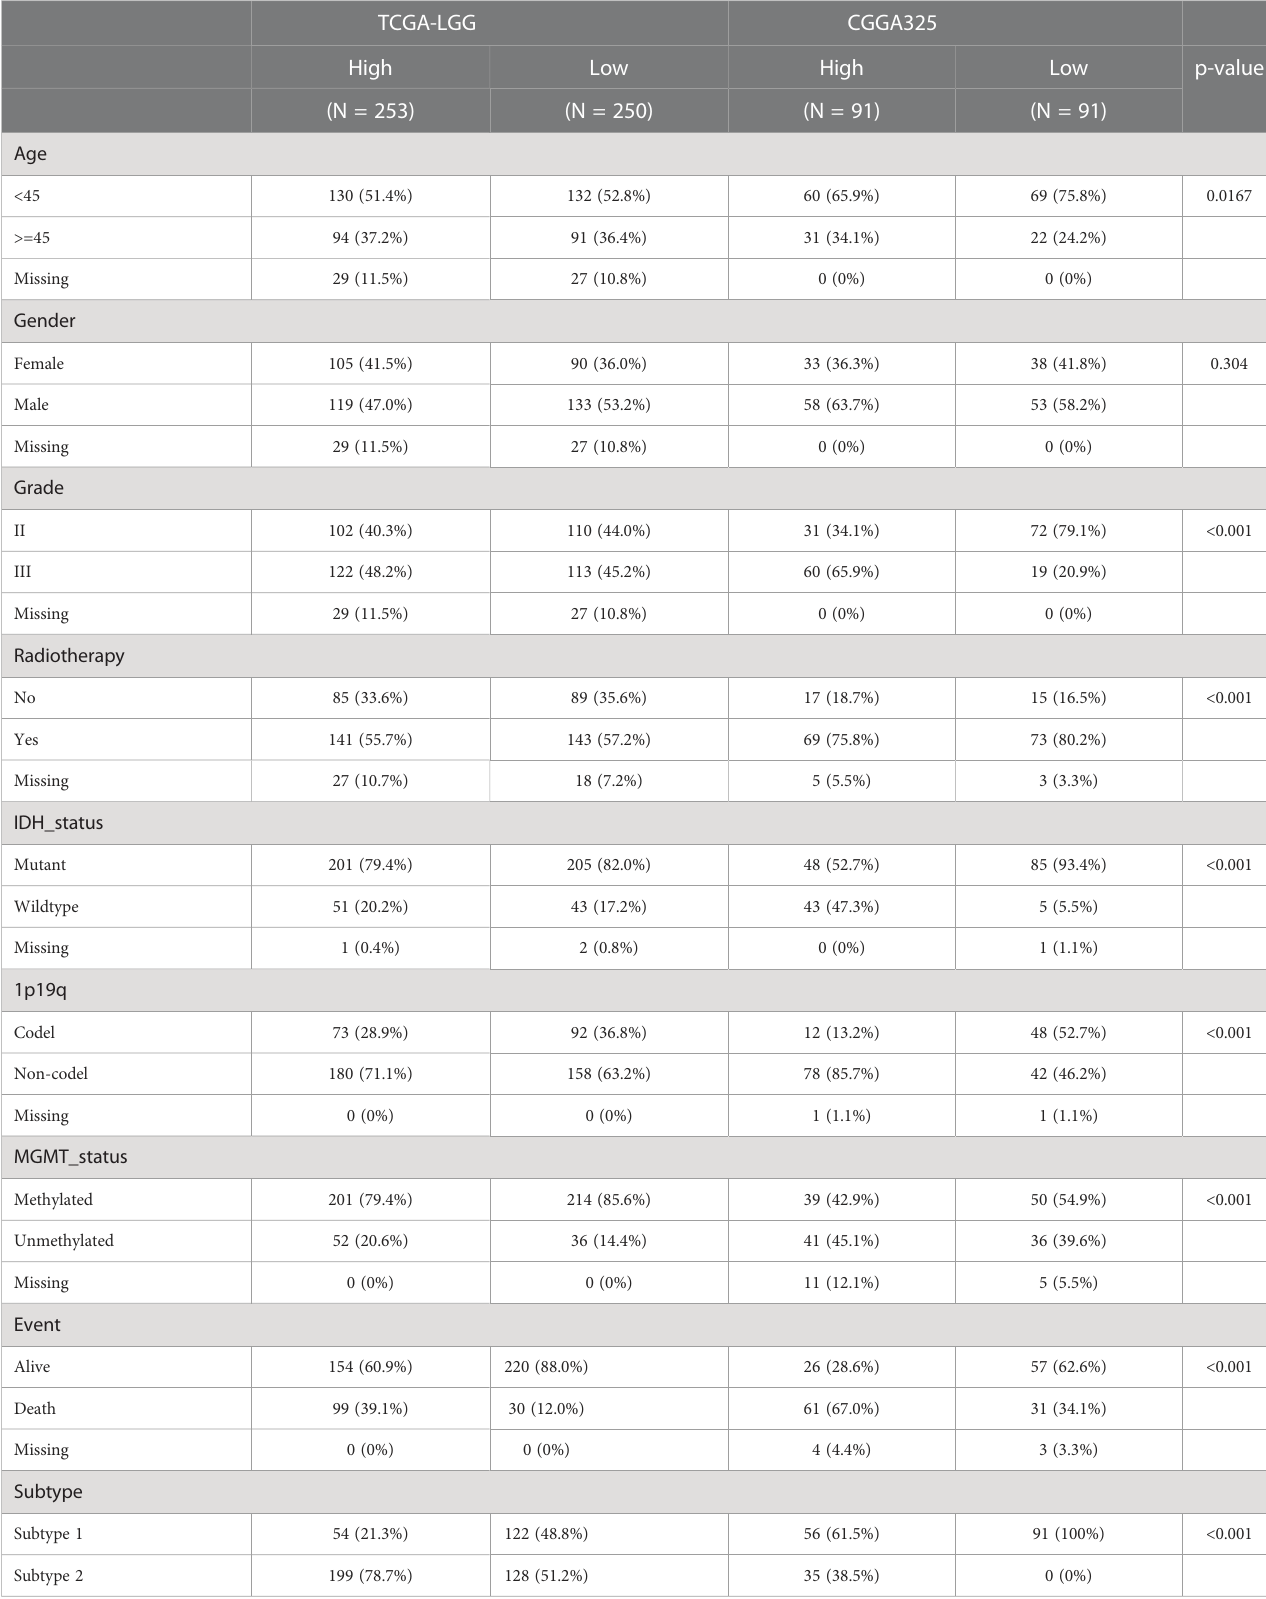
TABLE 1 clinicopathological characteristics between high-risk and low-risk group in TCGA-LGG and CGGA325